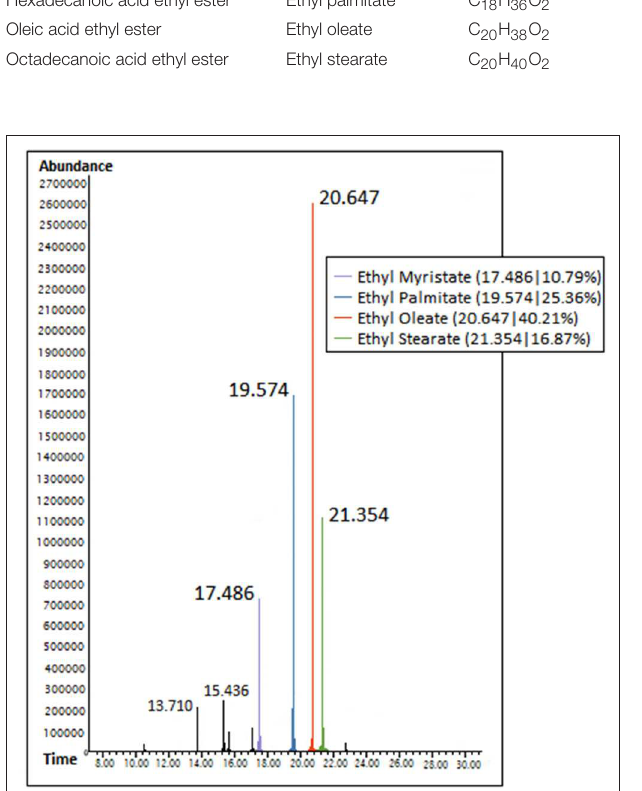
FIGURE 1 | GC Spectra of waste animal fat biodiesel.